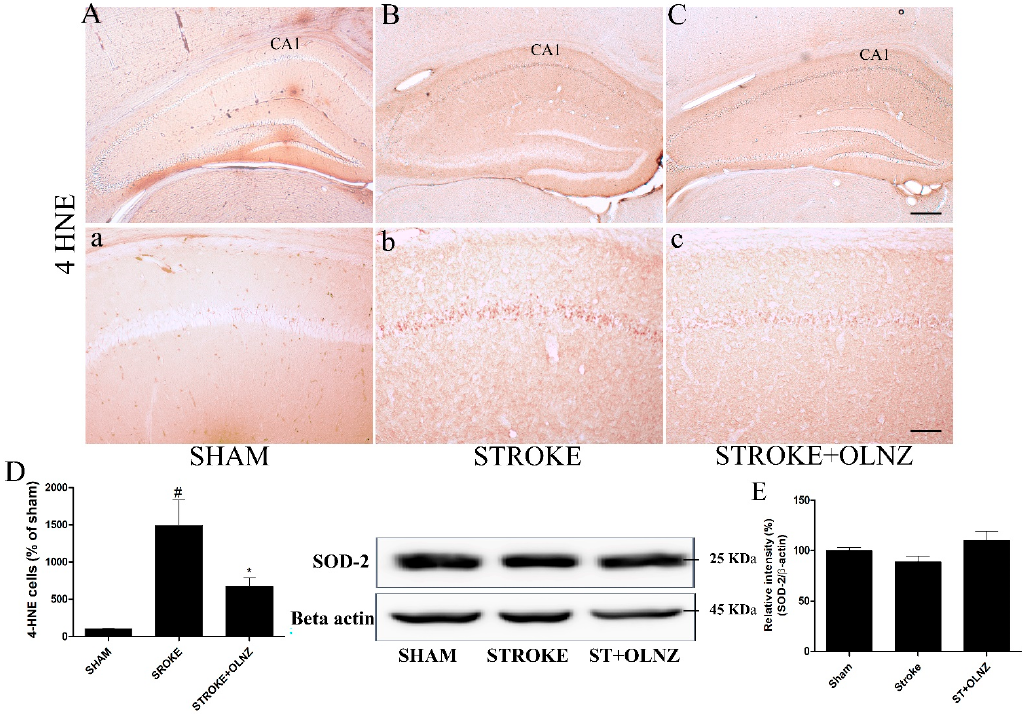
Figure 5. Role of OLNZ in 4-HNE immunoreactive cells in the CA1 area of the hippocampus. Identification of 4-HNE cells in the sham group ( A ) 10 × and ( a ) 200 × , TI-mediated ischemic stroke group ( B ) 10 × and ( b ) 200 × , and TI-mediated ischemic stroke + OLNZ (10 mg/kg) group ( C ) 10 × and ( c ) 200 × . ( D ) The graph signifies the relative numbers of immunoreactive 4-HNE cells. Effects of OLNZ on antioxidant enzyme (SOD-2) protein expression in hippocampal tissue. The expression of (%) ( E ) SOD-2 proteins was increased after treatment with OLNZ. Data were expressed as the mean ± SEM, n = 3 in each group. After performing one-way ANOVA with Tukey’s post hoc tests, p < 0.05 for comparisons of the treatment groups with the sham group (#) and p < 0.05 for comparisons with the TI-induced stroke group (*) were considered significant.